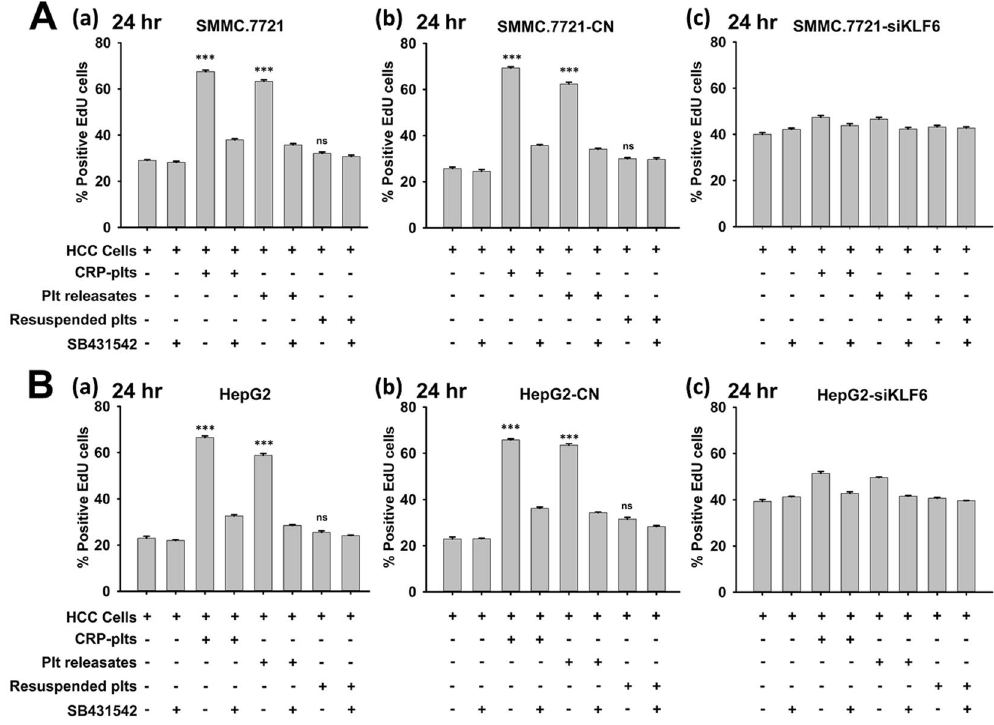
Figure 6. Platelet-derived TGF- β promotes HCC cell proliferation. ( A ) SMMC.7721 (a), control shRNA- transfected SMMC.7721 (b) and KLF6-silenced SMMC.7721 (c) cells were treated with platelets and their releasates in the absence and presence of TGF- β receptor inhibitor SB431542 (10 μ M). The EdU incorporation assay was used to determine the effects of platelets on tumor cell proliferationafter24 hours, and cells cultured in fresh medium were used as a control. ( B ) Quantification of EdU-positive HepG2 (a), control shRNA-transfected HepG2 (b) and KLF6-silenced HepG2 (c) cells, which had been treated with platelets and their releasates in the absence and presence of TGF- β receptor inhibitor SB431542 (10 μ M) for 24 hours; cells cultured in fresh medium were used as a control. For ( A ) and ( B ), each experiment was repeated at least 3 times in triplicates. Five fields were randomly selected and examined at x200 magnification for each group. Data are presented as the mean ± SEM. ( *** p < 0.001 compared with controls).